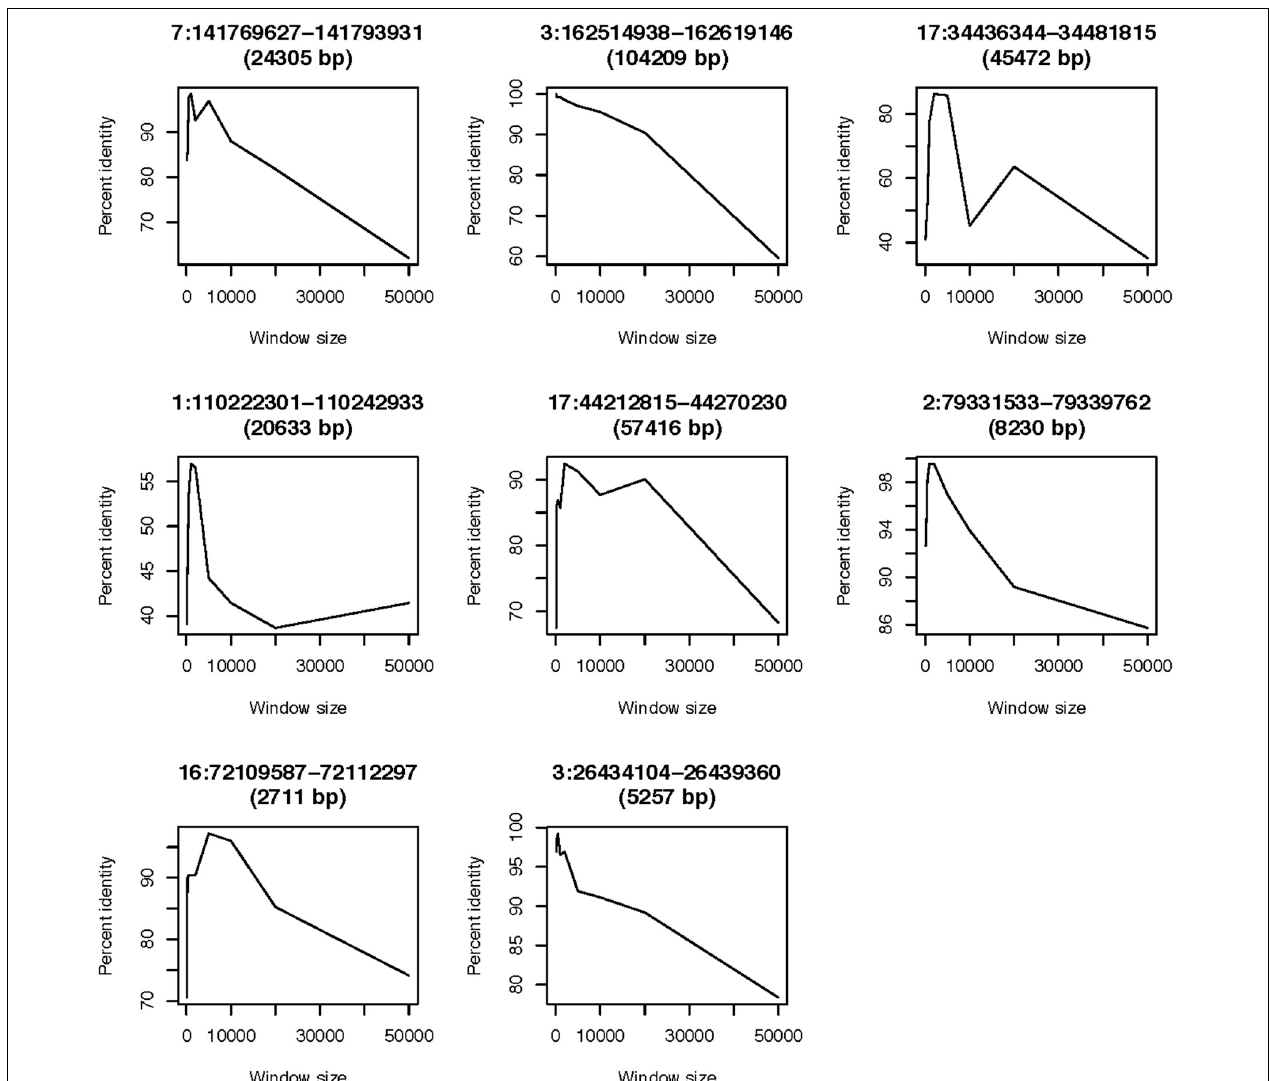
FIGURE 6 | Concordance between the CNVrd and microarray based results. Window sizes are shown on the x-axis, while the y-axis shows the percentage of identical results.